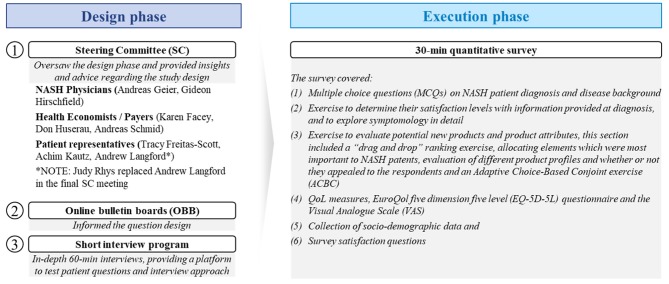
Methodology summary.